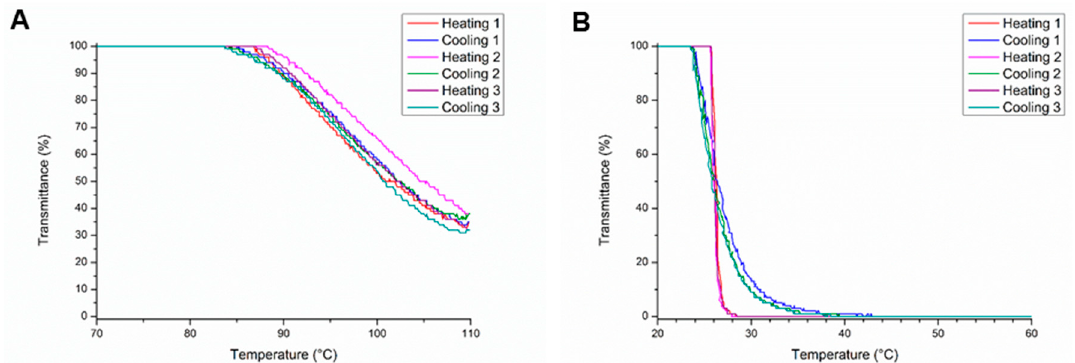
Figure 1. Turbidity measurements for ( A ) PMestOx and ( B ) PC3MestOx.